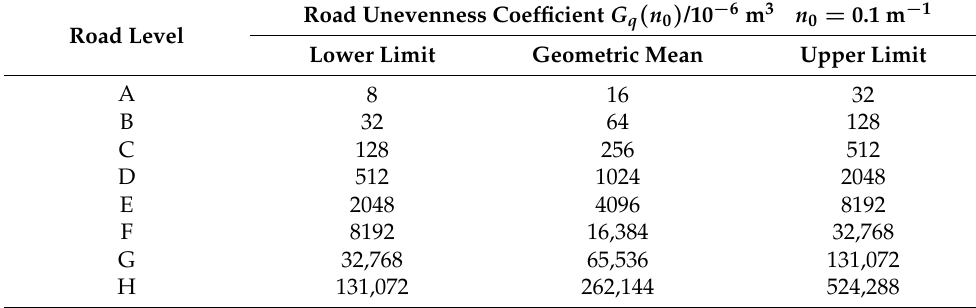
Table 1. Eight-level classification of road disturbance roughness. Road